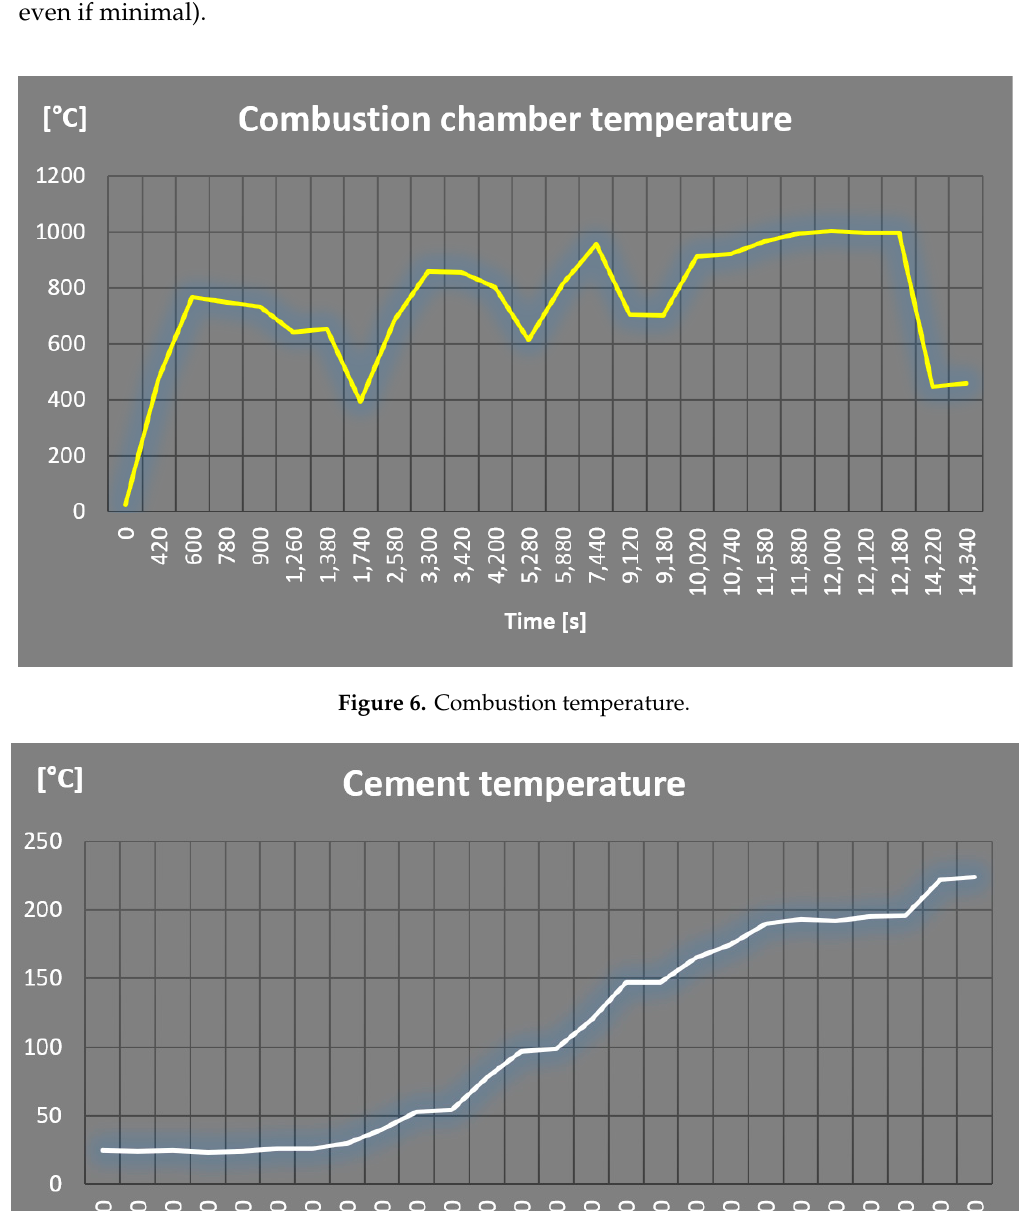
Figure 8. Evolution of the oxygen concentration in the exhaust gases.